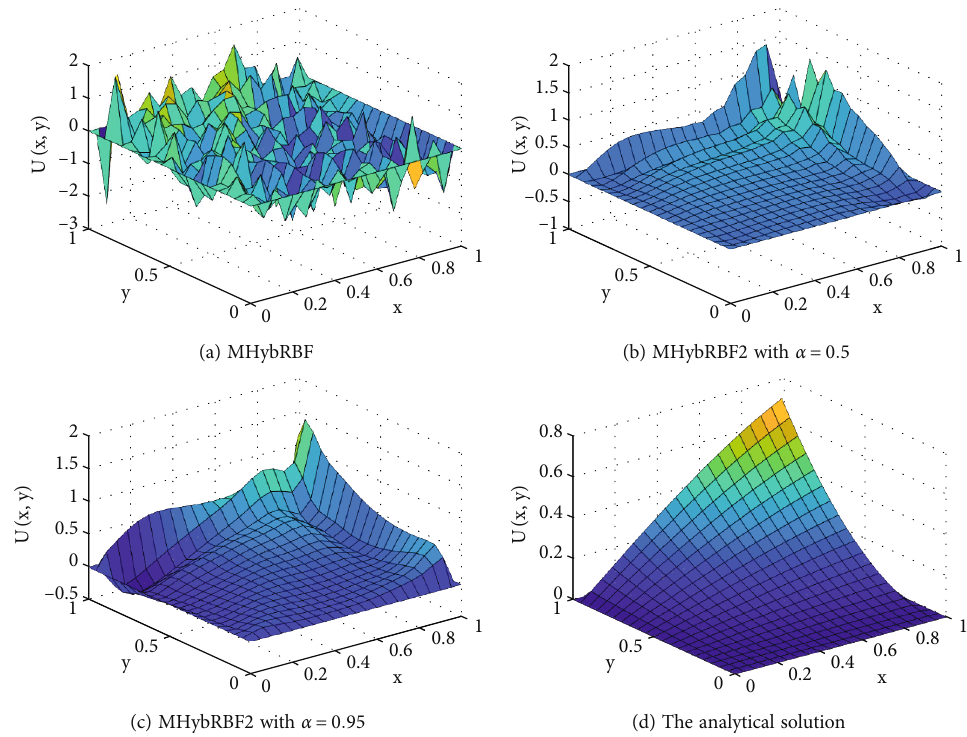
Figure 5: The comparison of the numerical results of MHybRBF with optimal α , ε and the analytical